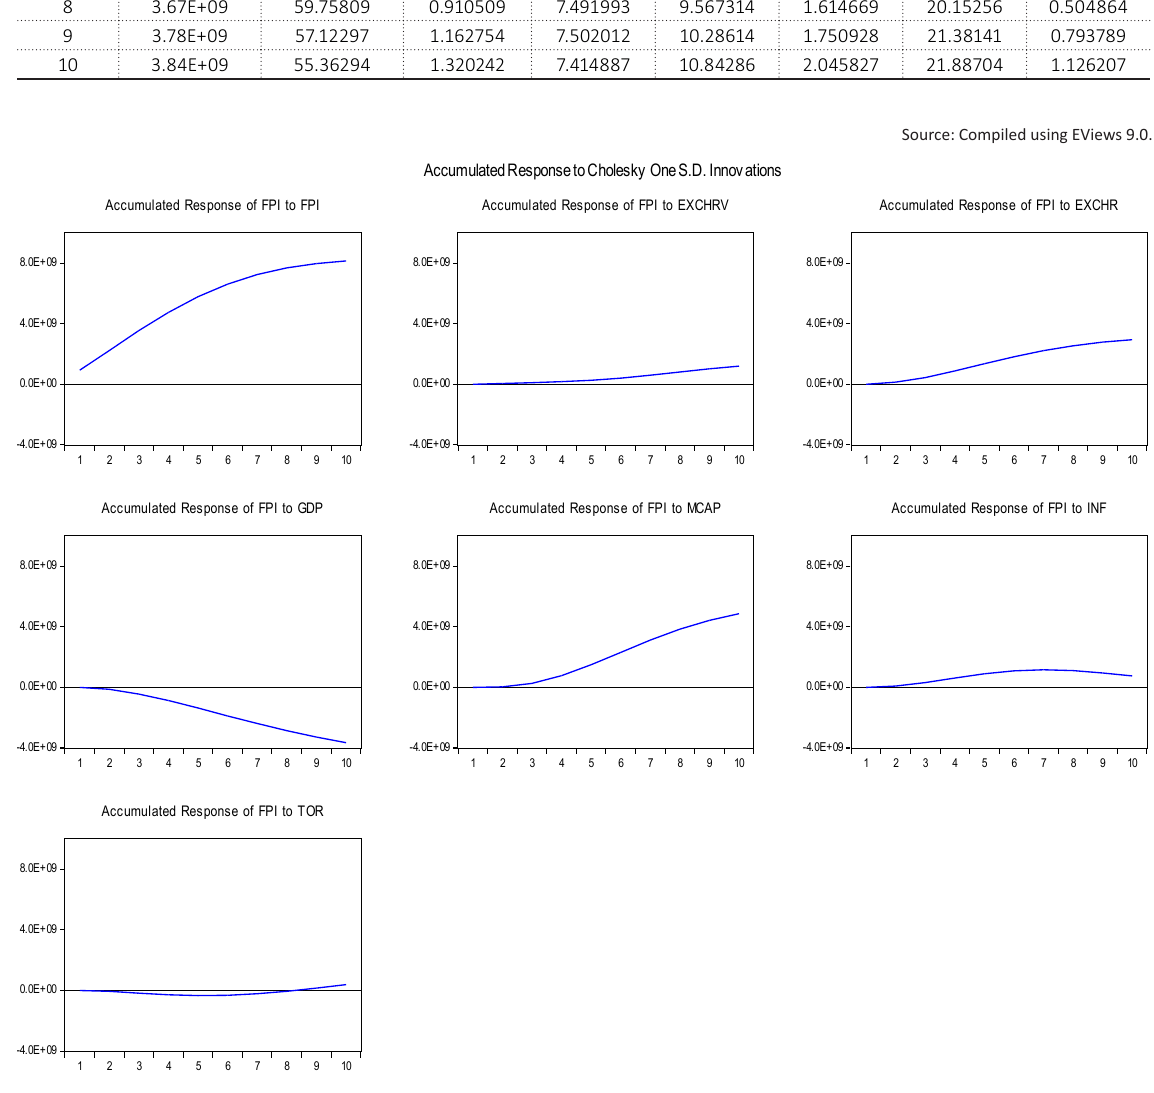
Figure A1. Accumulated response of